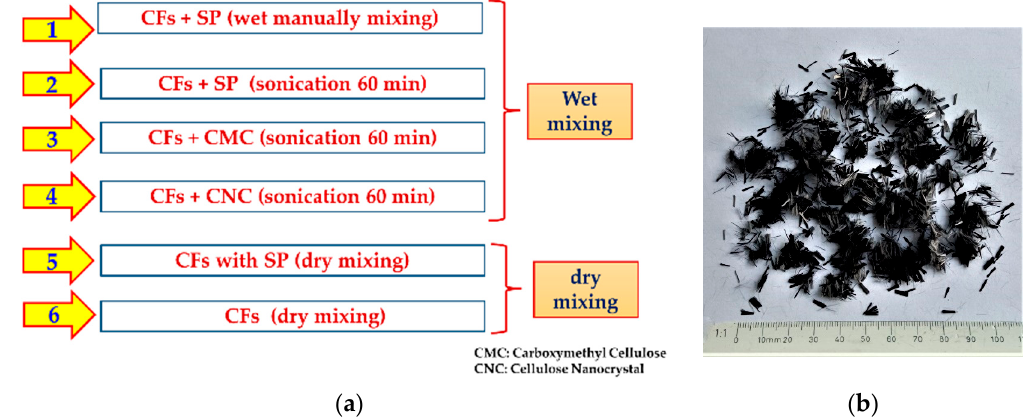
Figure 1. ( a ) Methods of 0.5 wt.% CFs introduction in cement pastes, ( b ) Carbon fibers (CFs). Table 1. Properties of Carbon fibers.